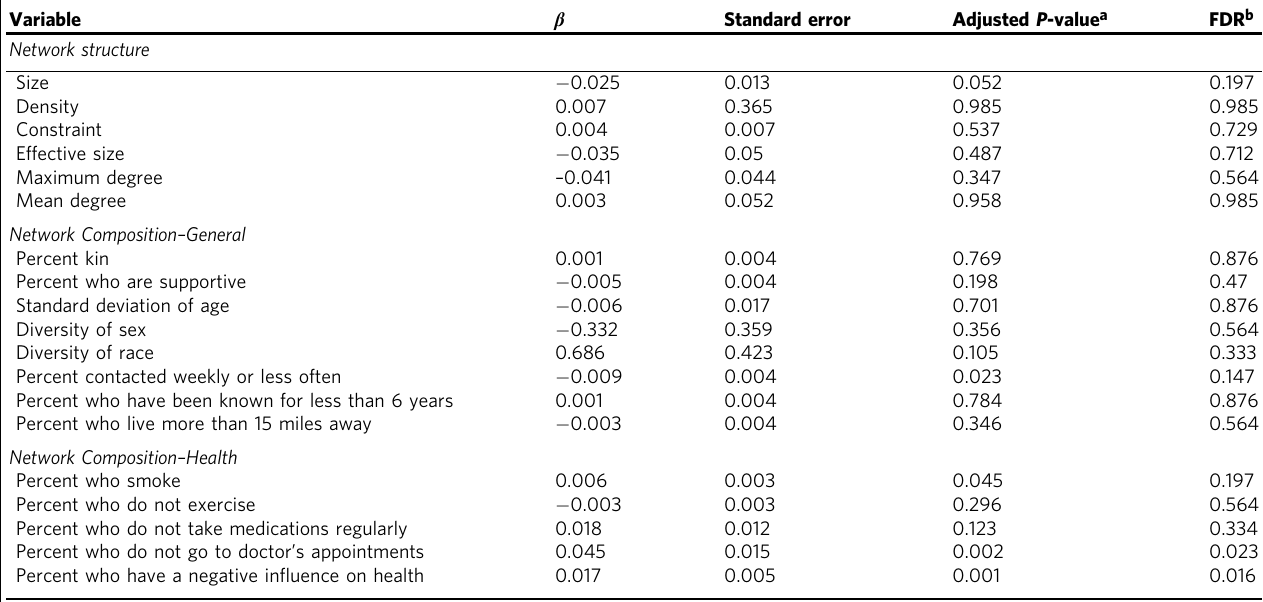
Table 4 Relationship of individual network variables to MSRS-R